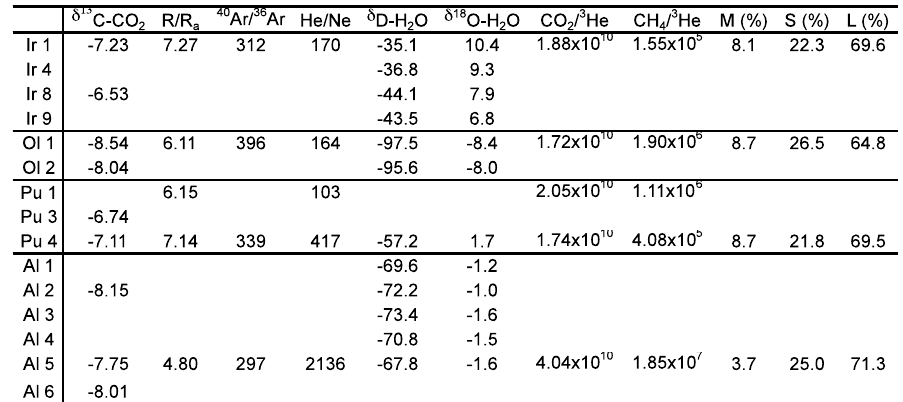
Table 3. d 13 C-CO (‰ V-PDB), R/Ra, d 18 O and d D (both in ‰ V-SMOW) values and 40 Ar/ 36 Ar, 4 He/ 20 Ne, CO 2 from the Irruputuncu (Ir), Olca (Ol), Putana (Pu) and Alitar (Al) volcanoes. L, S and M are the limestone, organic sediments and mantle end-members (%), as defined by Sano and Marty